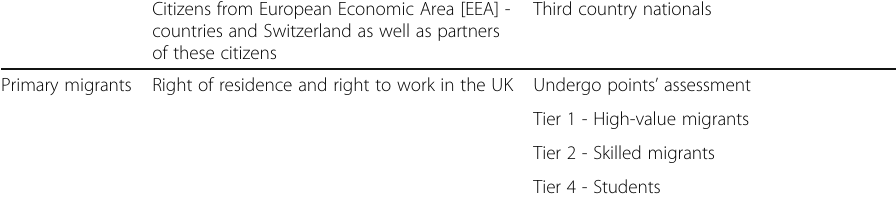
Third country nationals Tier 1 - High-value migrants Tier 2 - Skilled migrants Tier 4 - Students Points ’ based system dependants (Tier 1, 2, 4) can apply for visa to join primary migrant; have the right to work c , are not allowed to work as doctor/dentist in training [Immigration Rules